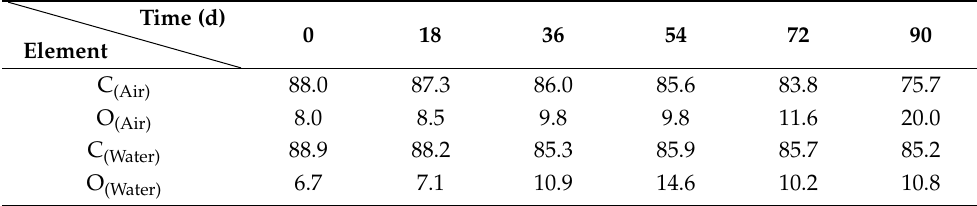
Table 3. Changes in C and O element content of different samples.